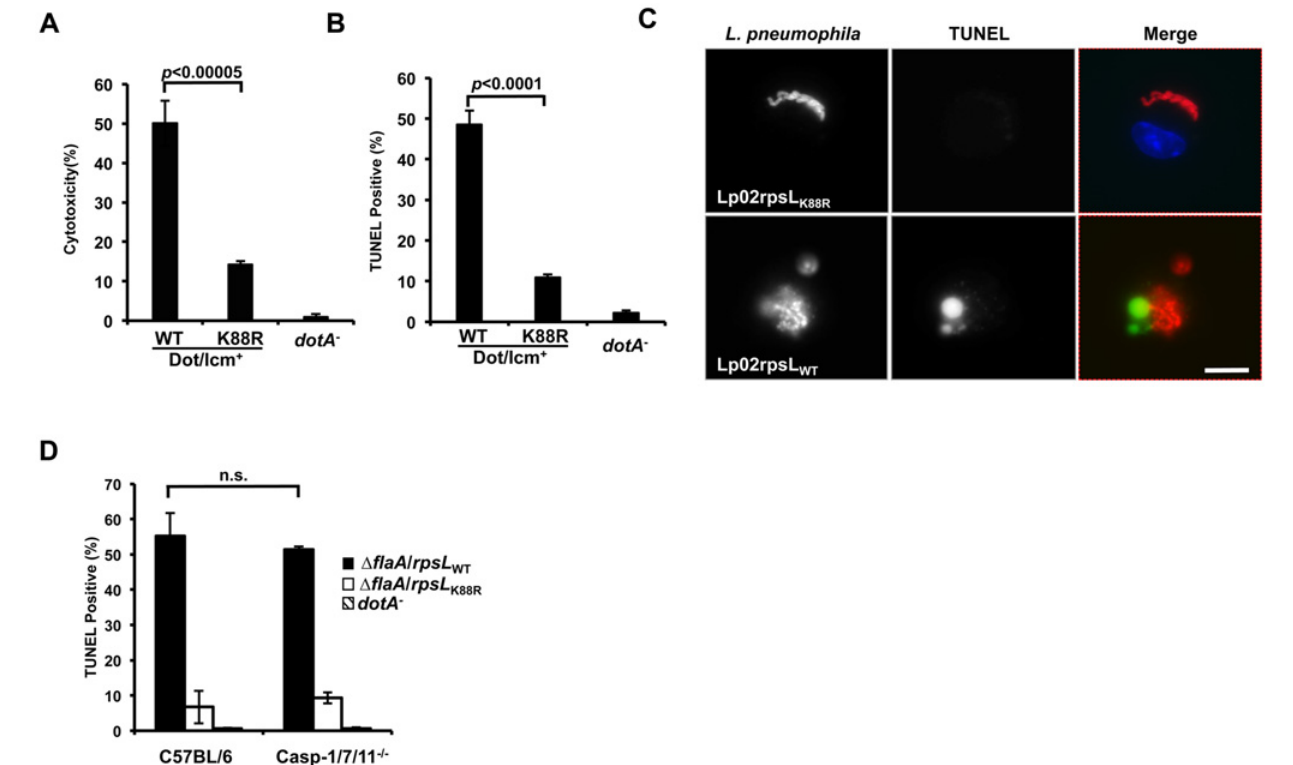
Fig 3. L . pneumophila strains harboring wild type rpsL caused cell death in infected macrophages. Bone marrow-derived macrophages from A/J mice were infected by the indicated bacterial strains for 14 hrs and health status of infected cells were evaluated by measuring the release of lactate dehydrogenase (LDH) ( A ) and by TUNEL staining ( B ) following by differently labeling extra- and intracellular bacterial by immunostaining. Infections were performed in triplicate and similar results were obtained in at least 3 independent experiments. For the TUNEL results, at least 300 infected cells were scored in each sample. C . Representative images of TUNEL signals and of bacterial phagosomes. Intracellular L . pneumophila bacteria were immunolabeled (red) with specific antibodies in BMDMs infected for 14 hrs; the status of host cell death was by TUNEL staining (green). Note the debris-like signals around the bacteria in samples infected with the strain harboring wild type RpsL. Images were acquired by a CCD camera with an Olympus IX-81 fluorescence microscope. Bar, 10 μ m. D . Cell death caused by L. pneumophila occurs independent of the three inflammatory caspases, caspase-3, 7 and 11. BMDMs prepared from mice lacking caspases-3, 7 and 11 or its parental line C57BL/6 were infected with indicated L . pneumophila strains for 14 hrs and samples were processed to determine cell death as described in B . Note that the strain expressing wild type RpsL caused cell death in BMDMs from both mouse lines. The deletion of the flaA gene is to eliminate the effects caused by the NAIP5 allele in these mouse lines in response to